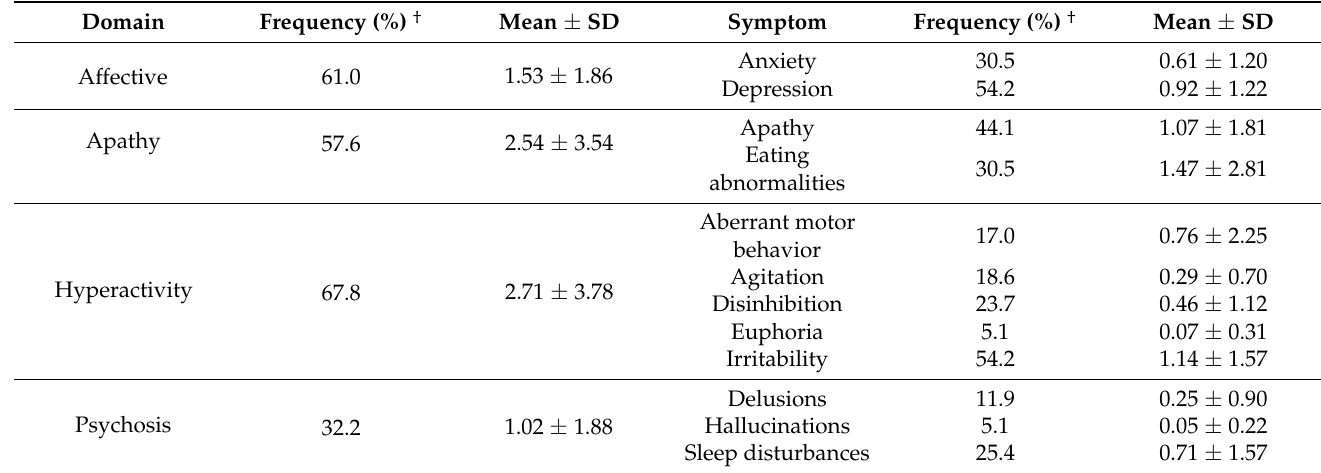
Table 1. Frequencies and scores of the neuropsychiatric symptom domains and corresponding symptoms